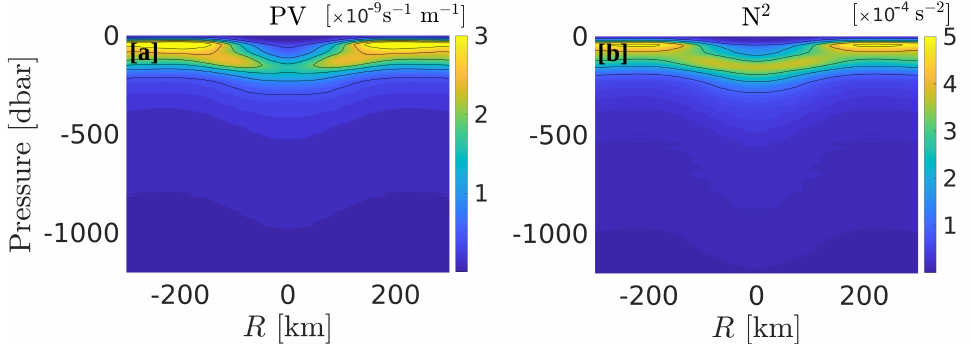
Figure 13. ( a ): Same as Figure 11 for potential vorticity. ( b ): same as ( a ) for the squared buoyancy